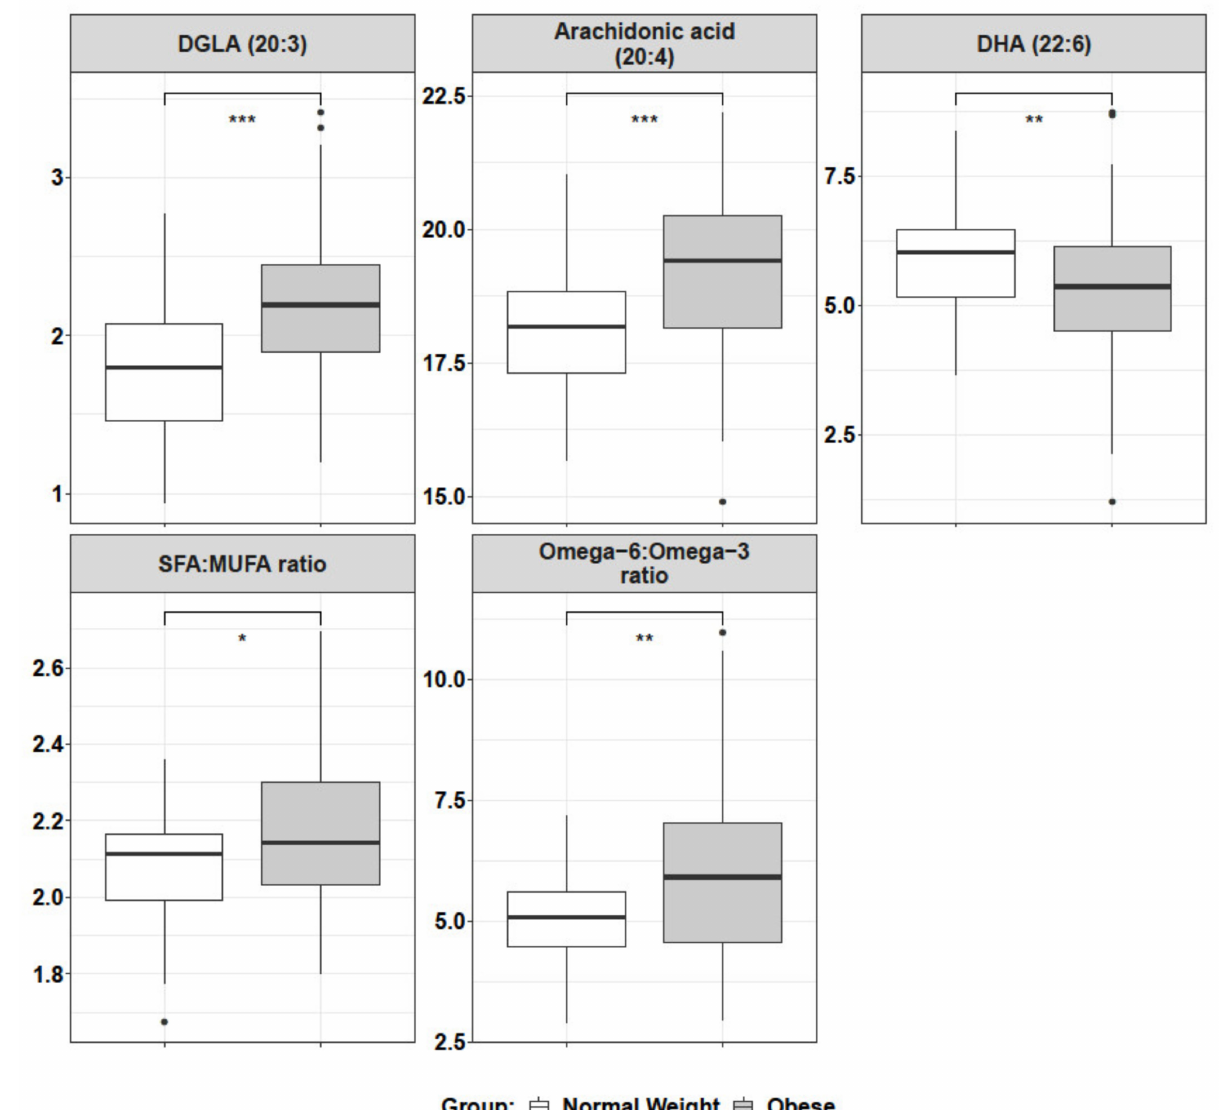
Figure 4. Lipidomic quantitation of global fatty acid presence in mature RBCs. Empty boxes refer to control (normal weight) group, while gray boxes represent obese patients. Significant differences are detected for dihomo- γ -linolenic acid (DGLA), arachidonic acid, DHA levels, SFA/MUFA, and ω -6/ ω -3 ratios, pointing to a metabolic switch for obese patient RBC membranes. Significance according to Student’s t-test: (*) p < 0.05; (**) p < 0.01; (***) p < 0.001. ( n = 49 for control, n = 52 for